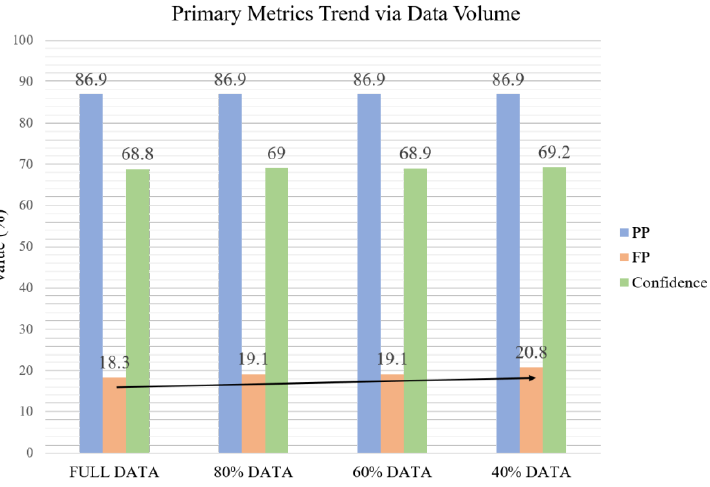
Figure 14. Accuracy trend according to the amount of learning traffic. Even when a small number of